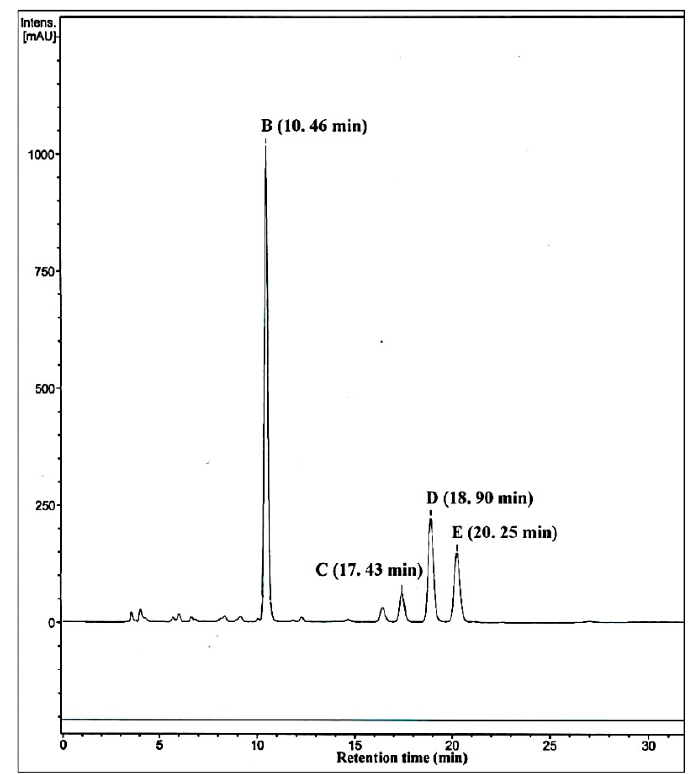
Figure 6. HPLC profile of a large scale incubation of methyltestosterone with M01A82WS72I. The four metabolites eluted at 10.46 (B), 17.43 (C), 18.90 (D) and 20.25 (E) min, respectively.